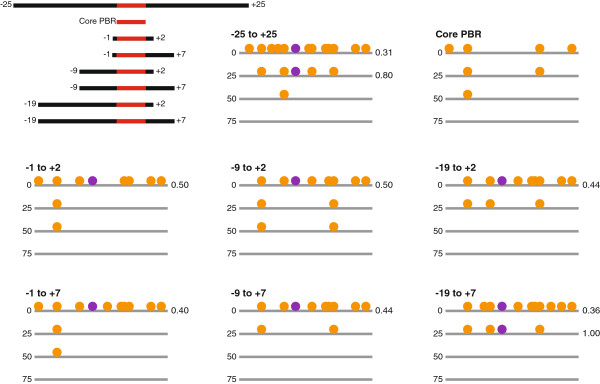
Low stringency HB binding site predictions in the IAB7b CRM. PWMs corresponding to the 7 bp core predicted binding region (PBR, red) or the core PBR with flanking sequences of various sizes (black) were used to predict HB binding sites in the 828 bp IAB7b enhancer with an initial cutoff threshold ln(p-value) = -6.77 (corresponding to the 25th percentile). For each individual PWM, a secondary cutoff at the 0th, 25th, 50th or 75th percentile of all the ranked sites (see Methods for details) was also applied. At this lower stringency primary cutoff score there are many more false positive binding sites predicted (orange circles). The core PBR fails to predict the true positive HB binding site (purple circle). The most robust predictions are made with the -19 to +7 PWM at the 25th percentile secondary cutoff, which predicts the true positive HB site and just three false positive sites (normalized value = 1.00, the relative performance of all other PWMs that predict the true positive HB site is measured against this value).